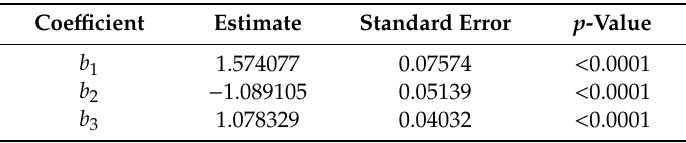
Table 1. Summary of nonlinear regression